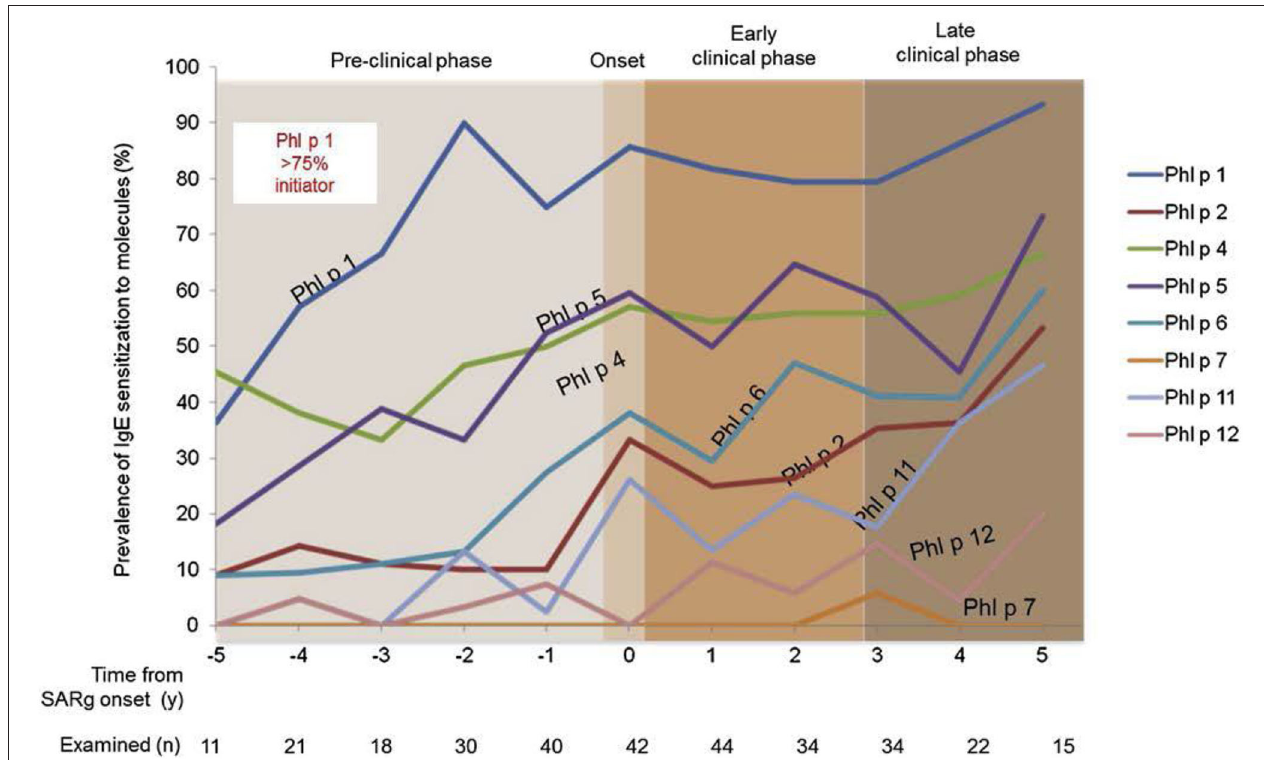
FIGURE 3 | Development of molecular IgE responses of children who developed grass pollen allergy in the first decade of life. Sequential blood samples were obtained in the preclinical phase as well as during the first 5 years with seasonal symptoms. Children were part of the prospective birth cohort study MAS (29).